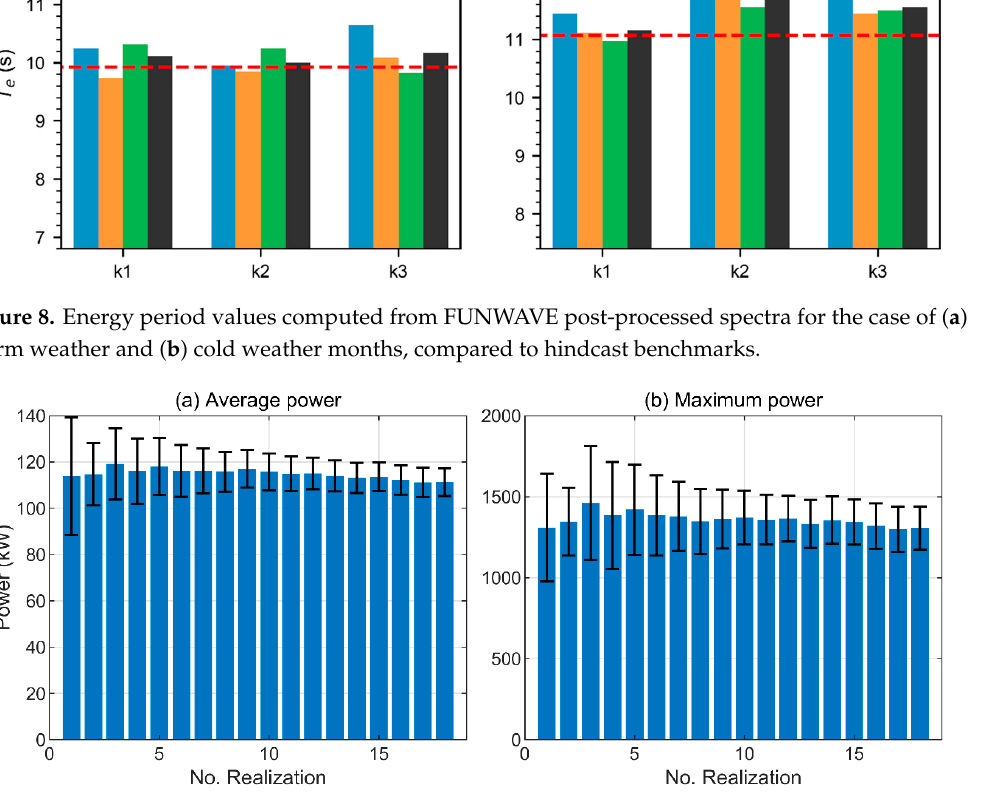
Figure 9. Uncertainty in simulation results due to the number of wave spectrum realizations for ( a ) maximum and ( b ) average power. Black error bars indicate the 95% confidence maximum and ( b ) average power. Black error bars indicate the 95% confidence interval.